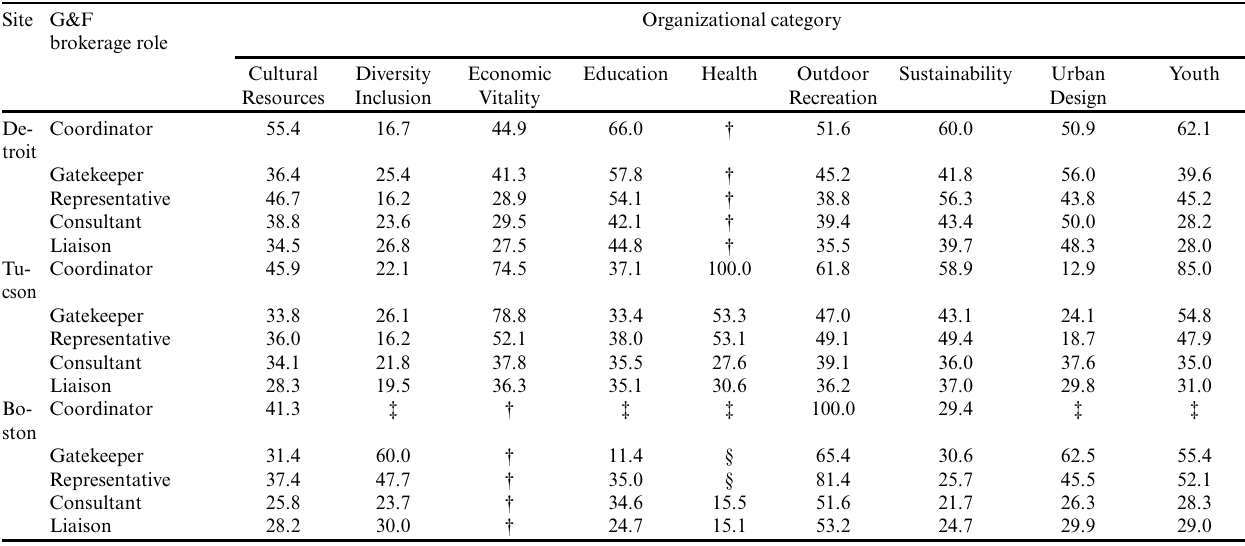
Table 7 . Percent capacity (%) in G&F brokerage roles for each organizational category in National Park Service urban collaborative networks in each site. Percent capacity reports the proportion of present to potential triads for each organizational category and G&F brokerage role in each site listed in Table